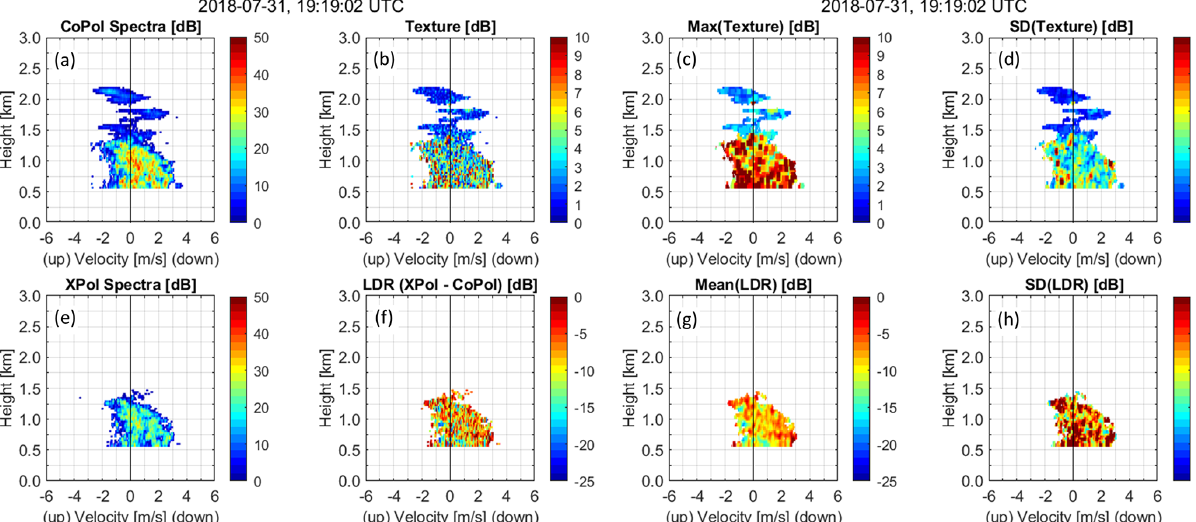
Figure 6. Spectra profile measurements and calculations from the profile at 19:19:02UTC on 31 July 2018. (a) CoPol spectra. (b) CoPol tex- ture. (c) Max(texture). (d) SD(texture). (e) XPol spectra. (f) LDR spectra. (g) Mean(LDR). (h) SD(LDR). All measurements and calculations are in units of dB.